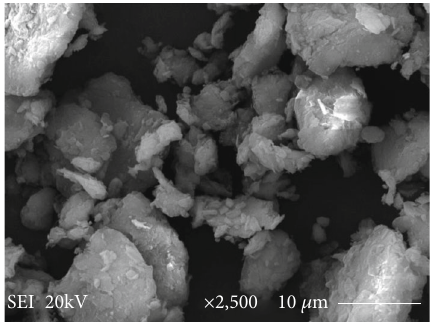
Figure 1: Vermiculite particles shape from SEM image.